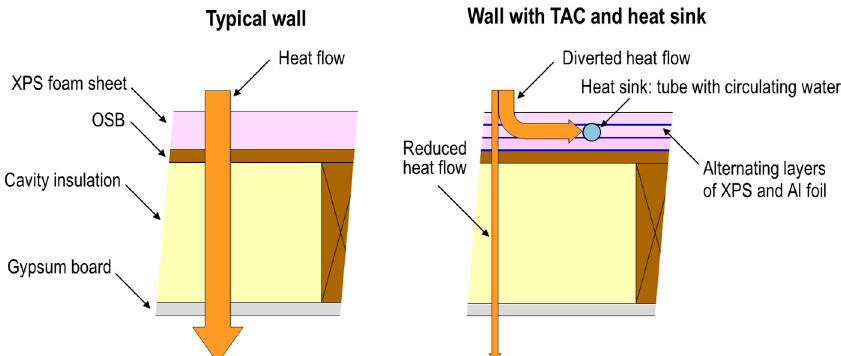
Figure 1. Conceptual operation of a thermally anisotropic composite (TAC)–heat sink combination applied to a wall to reduce heat gains during hot outdoor conditions.